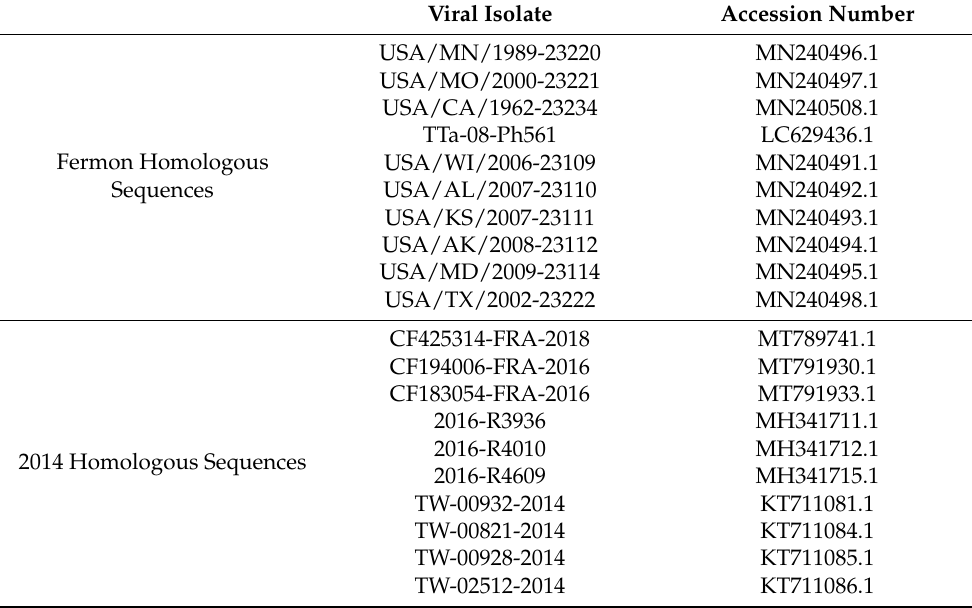
Table 1. Homologous Sequences Used in RNA Folding of the Fermon and 2014